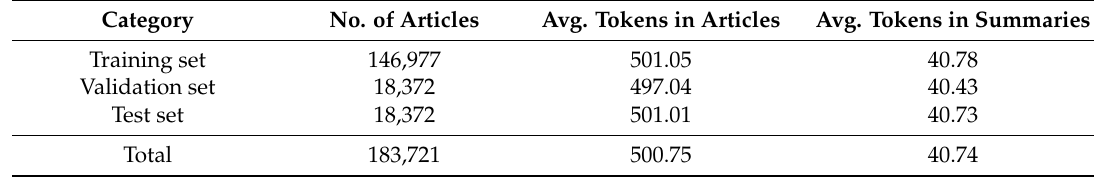
Table 3. Smple statistics on the training, validation, and test